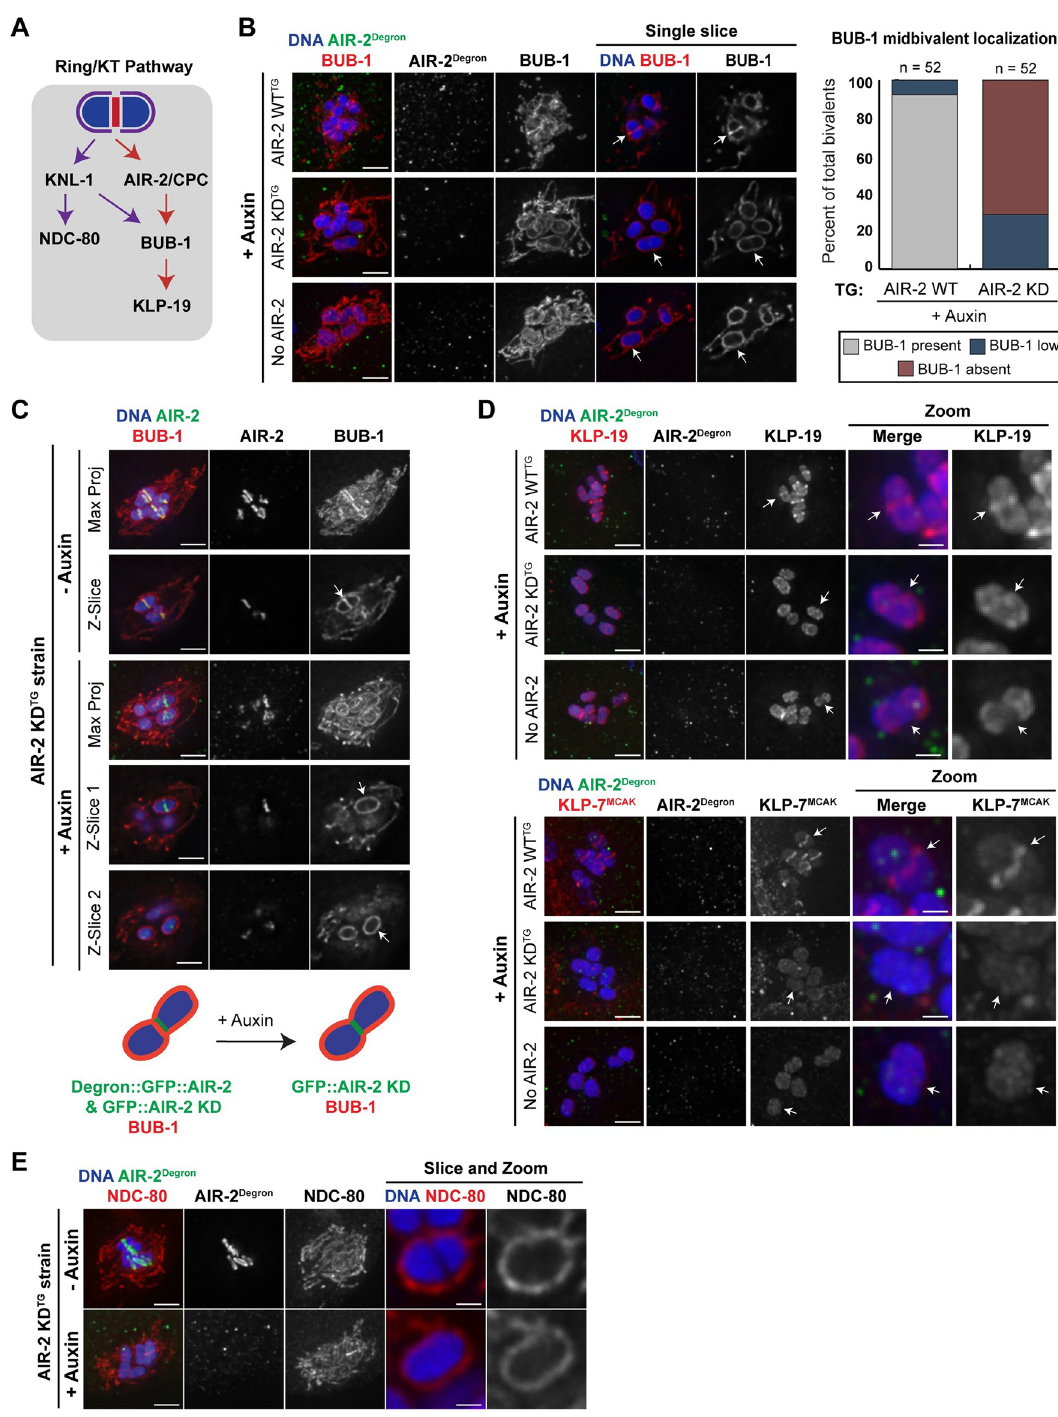
Fig 3. AIR-2 does not exclusively serve as a scaffold, and its kinase activity is required for ring complex assembly. (A) Schematic of known pathways of kinetochore (purple) and RC (red) assembly. (B) Localization of BUB-1 (red) on bivalents in the presence and absence of AIR-2 kinase activity; in all images endogenous AIR-2 (degron antibody, green) was depleted by auxin treatment. When wild-type transgenic AIR-2 is present in the oocyte, BUB-1 localizes to the midbivalent, cup-like kinetochores, and filaments. However, in the absence of AIR-2 or in the presence of kinase-dead AIR-2, BUB-1 does not localize to the midbivalent. The right two columns are single z-slices, to better show the midbivalent region (denoted with arrows). Quantification shown to the right of the